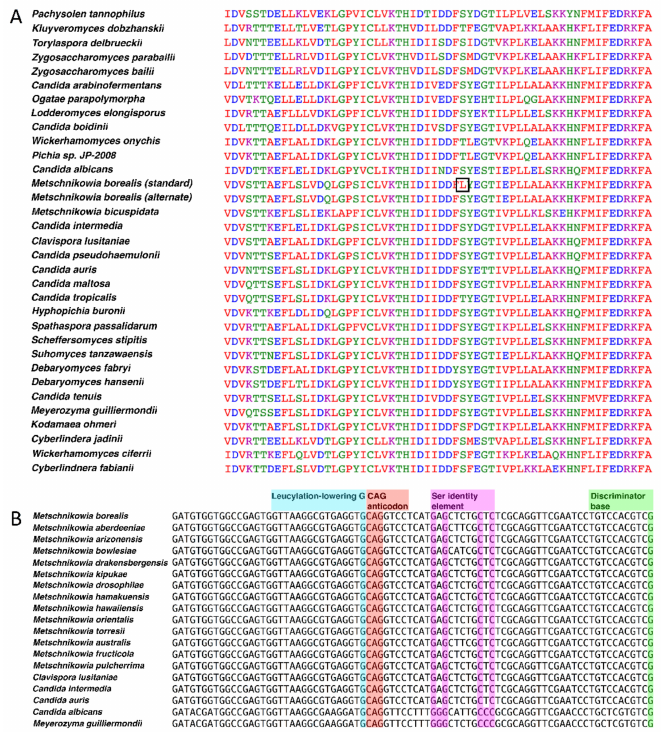
Figure 1. Bioinformatic analyses of the genetic code of M. borealis . ( A ) Sequence alignment of URA3 (encodes Orotidine 5'-phosphate decarboxylase). The coding sequence of URA3 from M. borealis was submitted as a query sequence to BLASTx, using the standard code for the predicted protein sequence. The protein sequences of the top 30 hits were aligned in MUSCLE with the M. borealis URA3 gene, translated in both the standard code and yeast alternative code using the ExPASy translate tool. A CUG codon aligned at a highly conserved serine or threonine amino acid position, producing a leucine when URA3 was translated using the standard code (black square). ( B ) tRNA CAG Ser sequences aligned for many species of Metschnikowia and various CUG-Ser yeasts. Sequences were aligned in MEGA6 and annotated as described previously